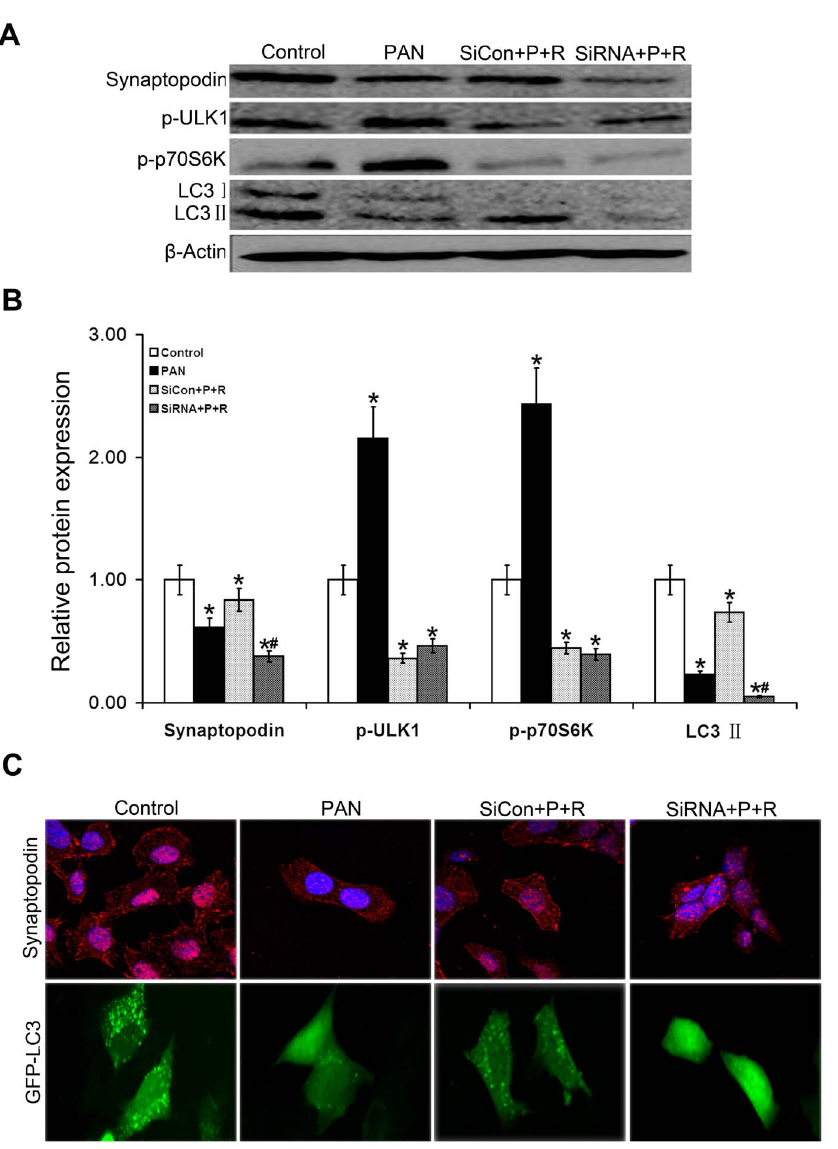
Figure 6. Aggravation of podocyte injury upon autophagy inhibition. (A–B).The Western blot results confirmed that the expression of synaptopodin and LC3 II was lower in ATG7 (a key protein of autophagy) RNAi-mediated knock down differentiated MPCs (siRNA + R + P) than in the siRNA negative control group (siCon + R + P). Both groups were pretreated with rapamycin and treated with PAN,* P , 0.05 vs Control, # P , 0.05 vs siCon + R + P. (C).In the presence of siRNA interference, GFP-LC3 granular expression (green fluorescence) nearly disappeared and cells appeared unhealthy with long and narrow nuclei. Synaptopodin expression (red fluorescence) was significantly downregulated. Magnification = 6 1200.